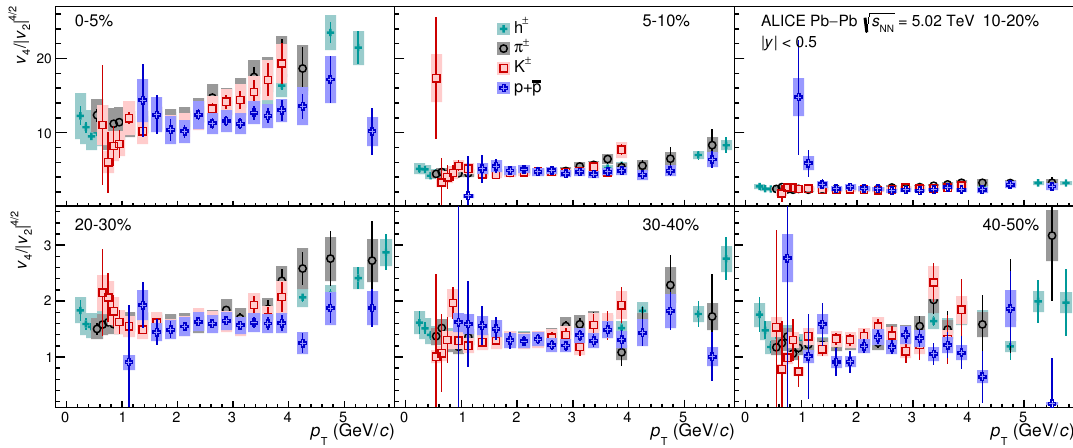
Figure 21 . (Colour online) Centrality dependence of v 4 = j v 2 j 4 = 2 for inclusive charged particles [44], (cid:25) (cid:6) , K (cid:6) , and p+p. Statistical and systematic uncertainties are shown as bars and boxes, respectively. v = j v j 4 = 3 , no p dependence is observed over the full centrality range. Large statistical 4 3 T uncertainties do not allow conclusions to be drawn on the behaviour of p+p v v = j v j 4 = 3 4 3